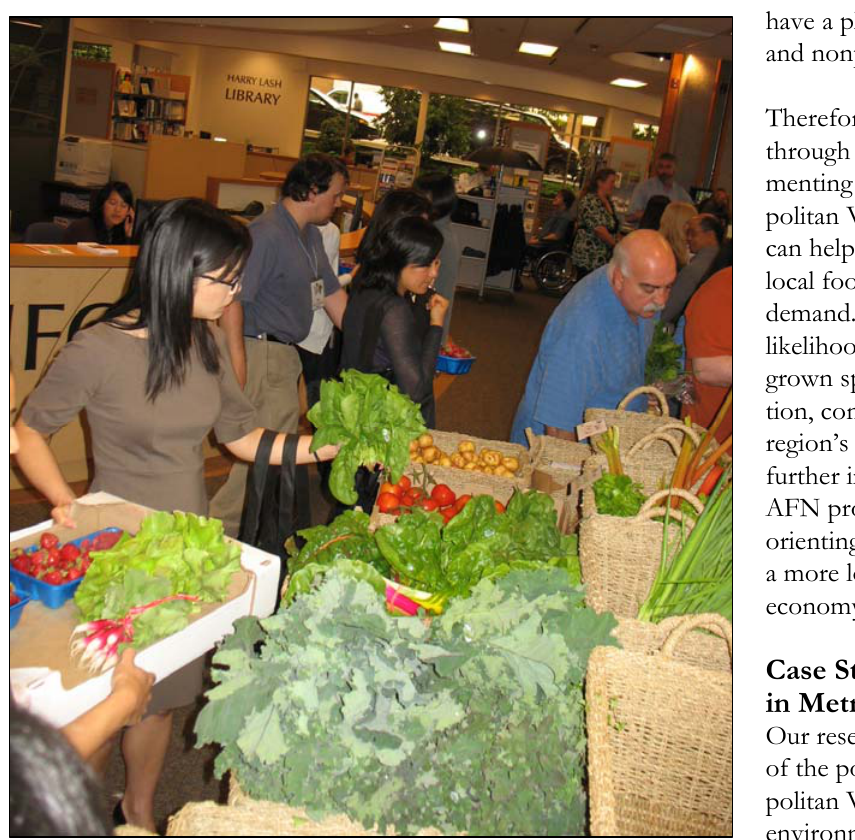
Figure 3. Indoor Pocket